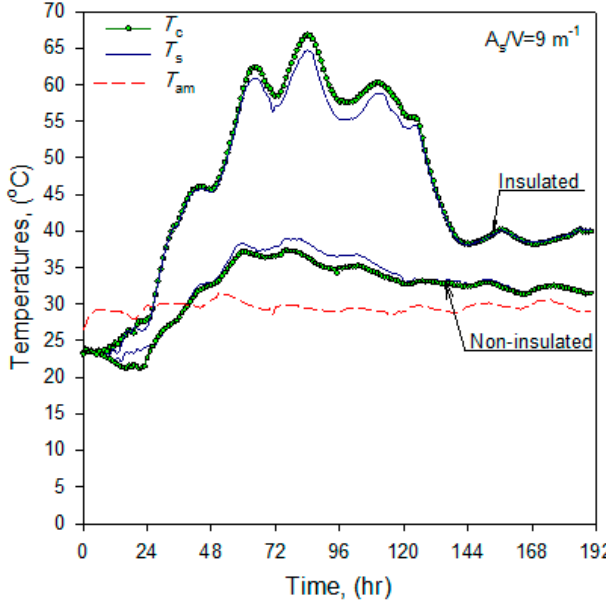
Figure 5. Time course of temperatures (compost, T c , outer surface of the bioreactor walls, T s , and ambient air, T am ) measured for insulated and non-insulated bioreactors during the composting process.